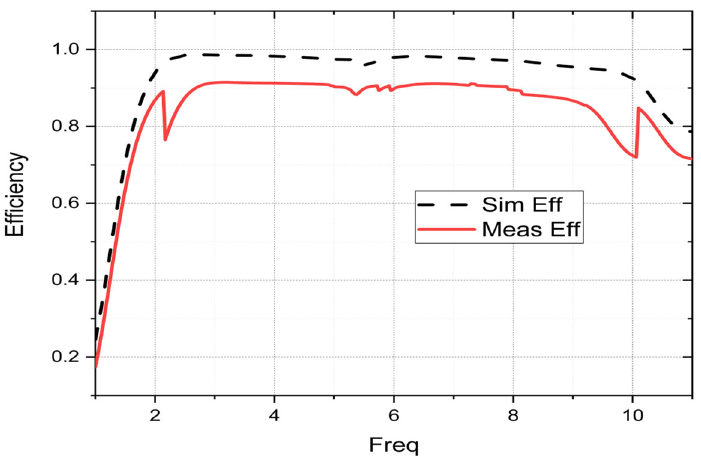
Figure 11. Radiation efficiency of the suggested patch.